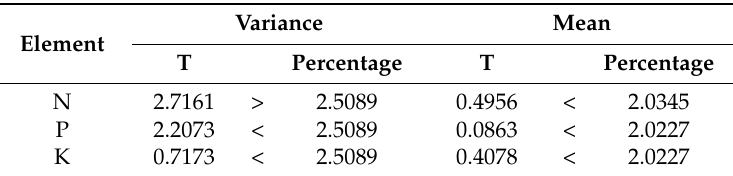
Table 7. The test statistics and the F -test and t -test critical percentages for a comparison of variances in N, P, and K concentrations.